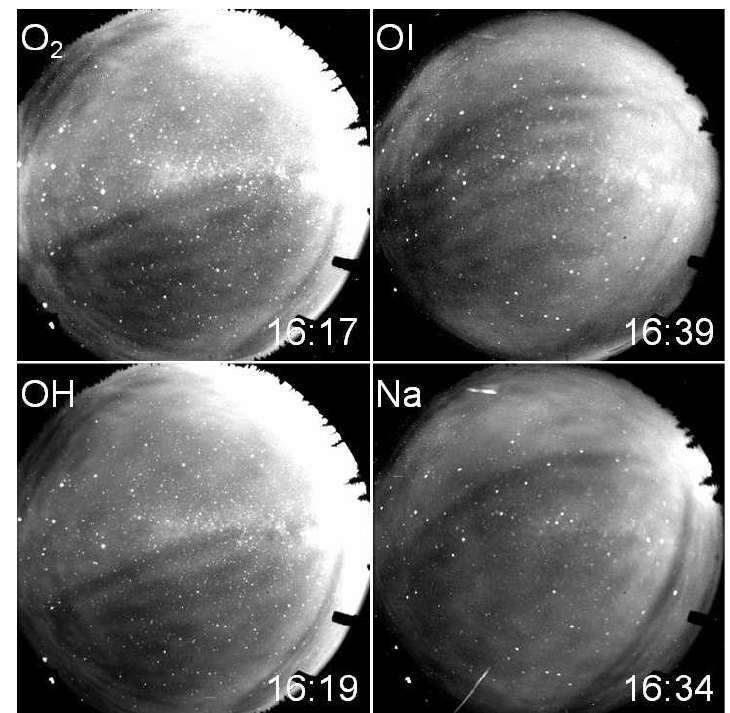
Fig. 2. Example all-sky images recorded in the OI, O 2 , Na, and OH emissions on 27/28 January. The two images to the left are taken near simultaneously and show a wave propagating across the field from the lower right towards the upper left in the OH and O 2 emissions . Another wave entering the field of view is barely visible to the lower right. The right panels show the same waves at a later time in the Na and OI emissions. The progression of the waves are evident. Also seen in the Na emission is a Super Loki rocket just after launch. The displayed times are in UT.